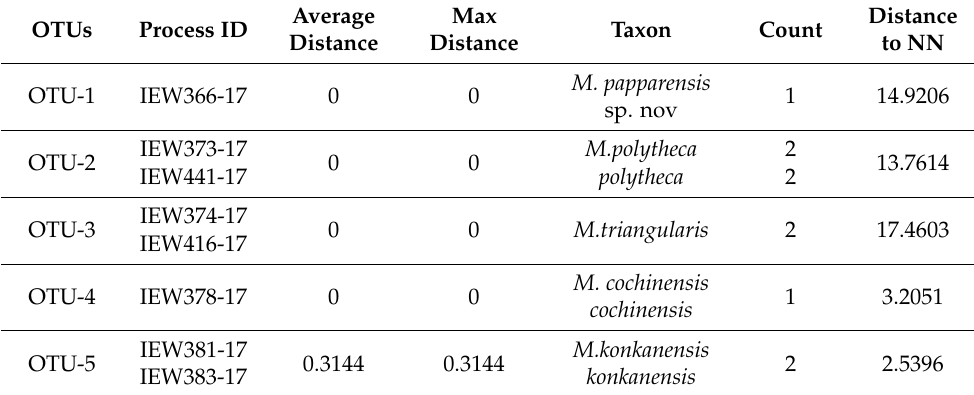
Table 2. Cluster Sequencing of COI barcodes of Megascolex species of Kerala depicting distances to nearest neighbour